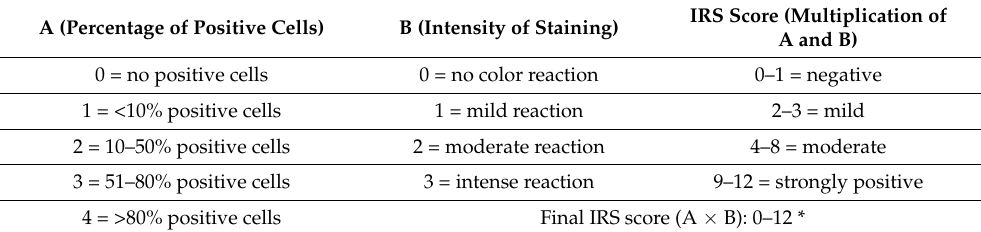
Table 2. Immunoreactive score system (IRS)